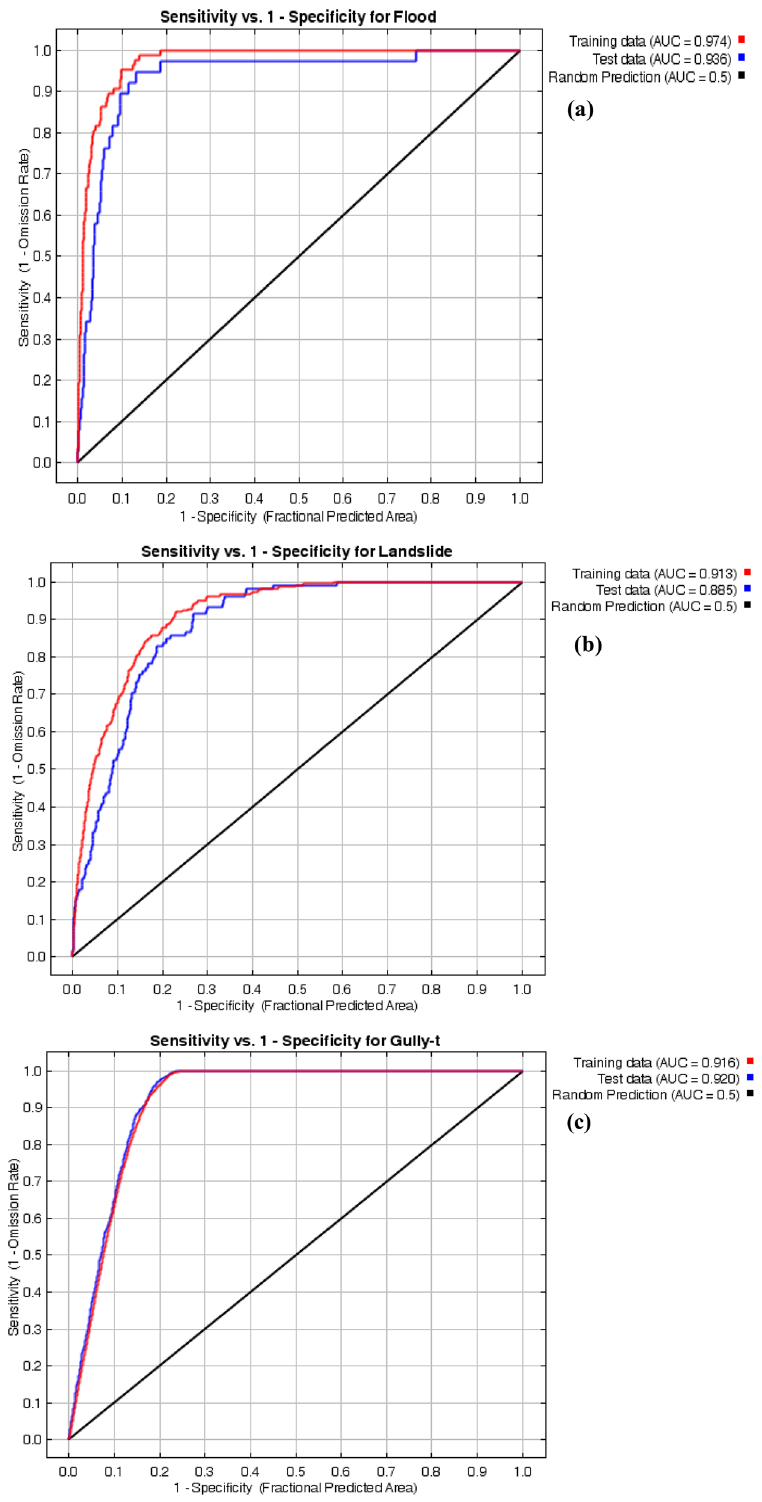
Figure 6. ROC curves of one data set (S1) for three hazards ( a ) landslides, ( b ) floods, and ( c )